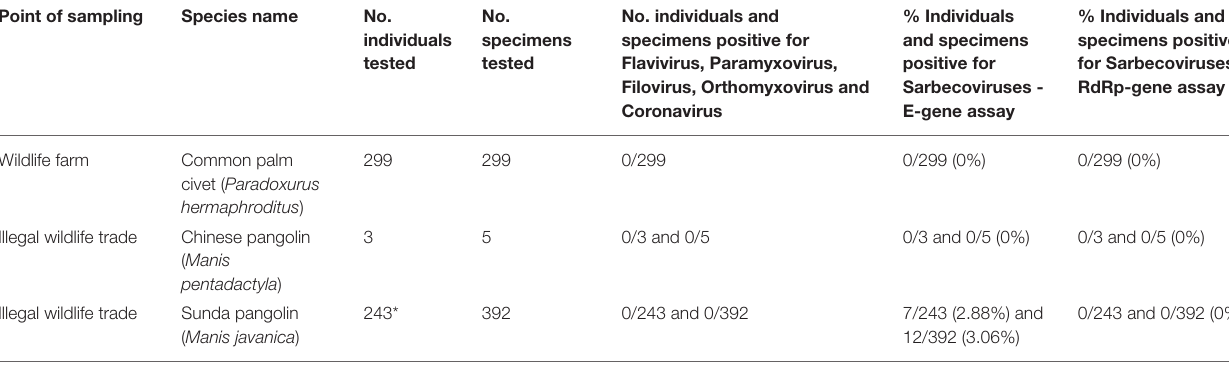
TABLE 3 | Results of pangolin and civet sample testing for five viral families using conventional PCR protocols and for SARS-COV-2 using the real-time reverse-transcriptase PCR (RT-PCR) assays targeting the E gene and RdRp gene (28). Point of sampling